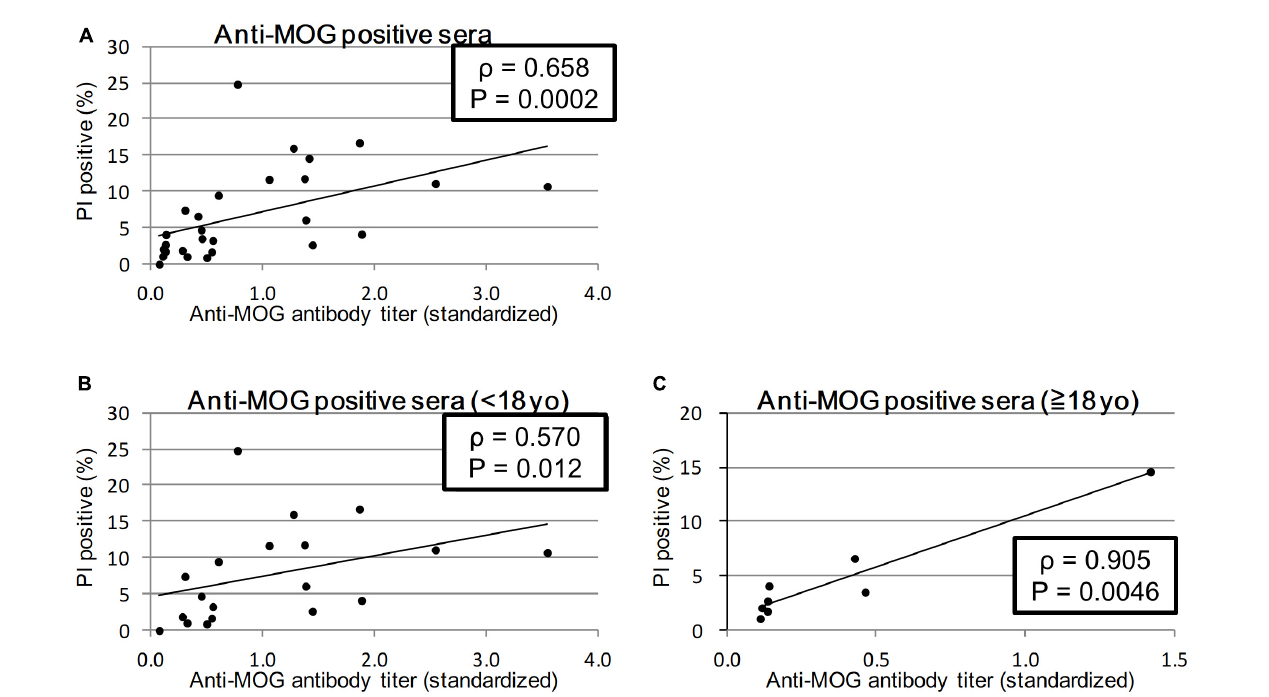
FIGURE3 Correlation between anti-MOG antibody titer ratio and cytotoxicity (proportion of PI-positive cells). Twenty-seven MOG-IgG-positive samples including 19 from children and 8 from adults were examined. Among all patients (sera with the highest antibody titer of each patient) (A) and comparison of child patients ( < 18 years old) (B) , and adult patients ( ≥ 18 years old) (C) . Antibody titers are adjusted for the value of standard serum for each experiment. Spearman’s rank correlation coefficient ( ρ ) and P -values are calculated and shown in each